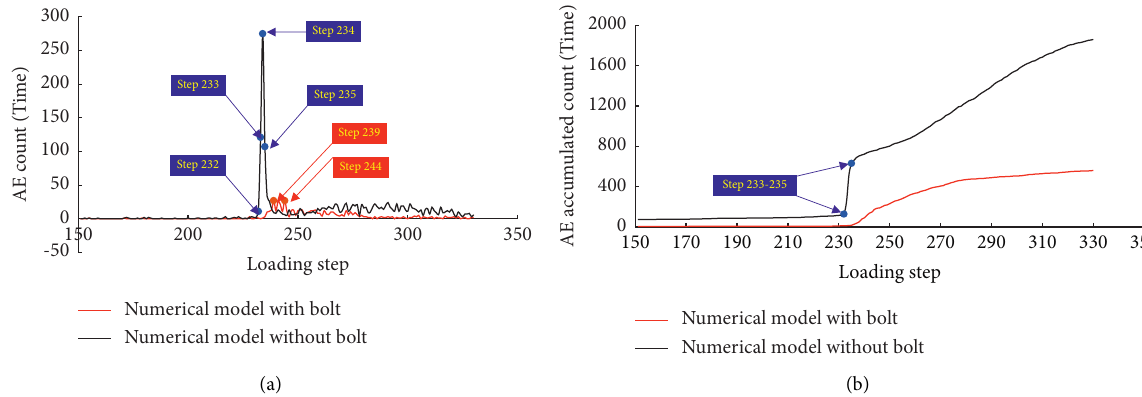
Figure 3: AE curve comparison of the two numerical models with bolt and without bolt. (a) AE count. (b) AE accumulated count.